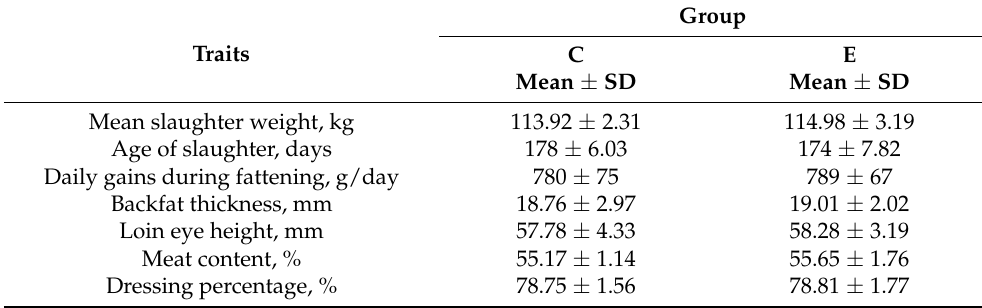
Table 3. Fattening and slaughter value